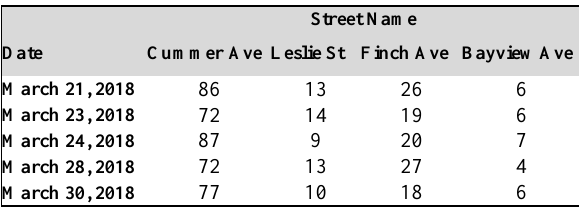
Table 1. Total number of detected road surface anomalies for each road segment in each time of survey